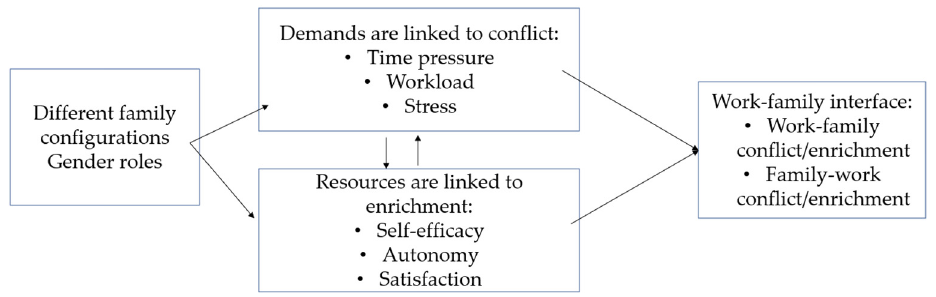
Figure 1. Work–family interface model.